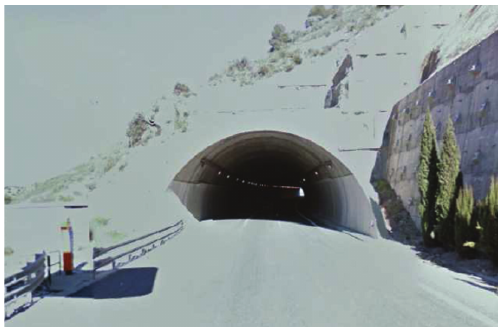
Figure 4: Modelled road tunnel in Pegalajar (Ja´en, Spain) with an almost perfect south-north orientation (349.41 ◦